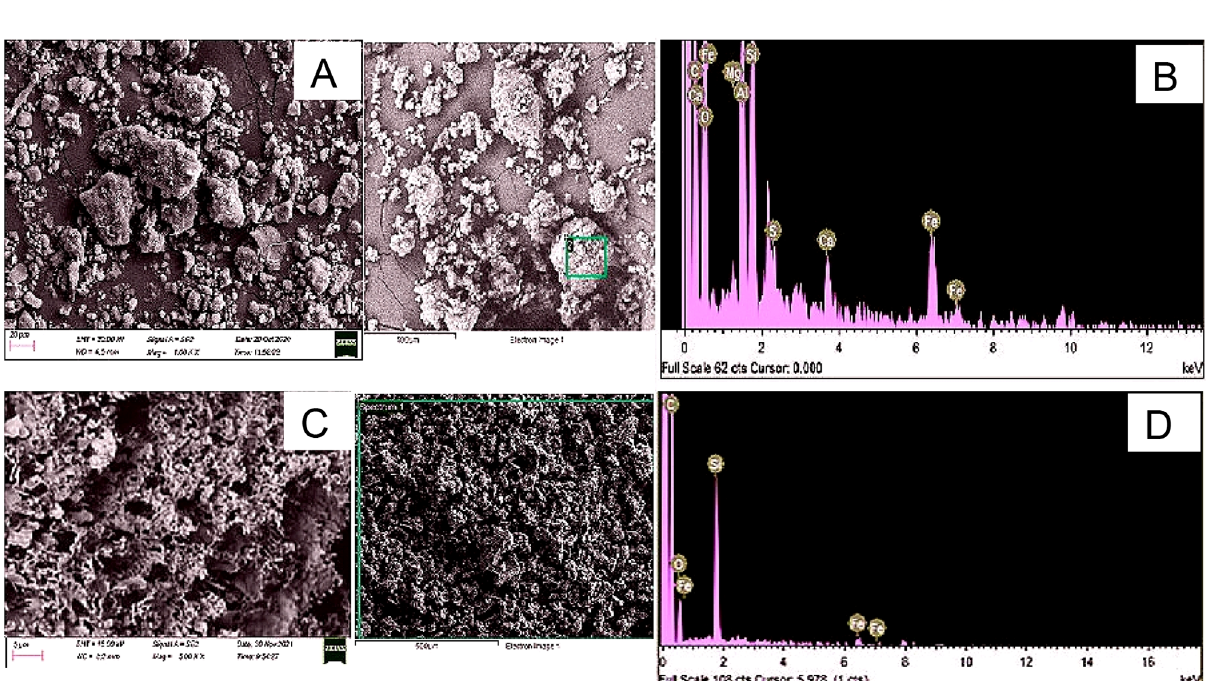
Figure 13. SEM images ( A , C ) and EDX elemental spectrums ( B , D ) of the mixture of coals and sewage sludge blended in optimized ratio (1CT + 1CS:0.4SS) (up), and the Co-HTC produced hydrochar (HCB)